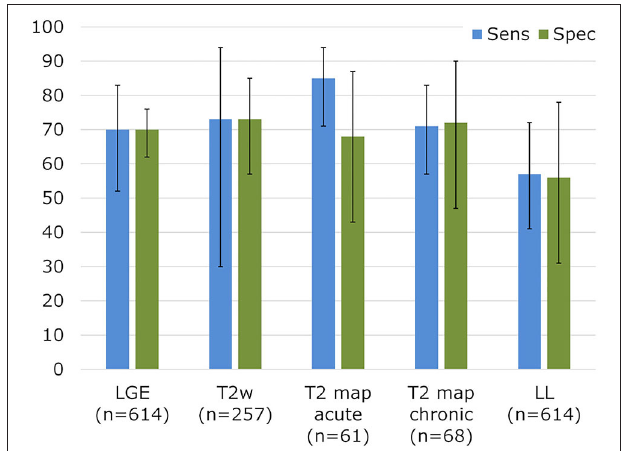
FIGURE 4 | Sensitivity and specificity for established CMR parameters in biopsy-proven myocarditis. Diagnostic performance for myocarditis detection in a meta-analysis for LGE, T 2 -weighted imaging, and Lake Louise (LL) criteria. T 2 mapping results vs. biopsies were collected from Lurz et al. ( 35). Adapted with permission from Mahrholdt et al.